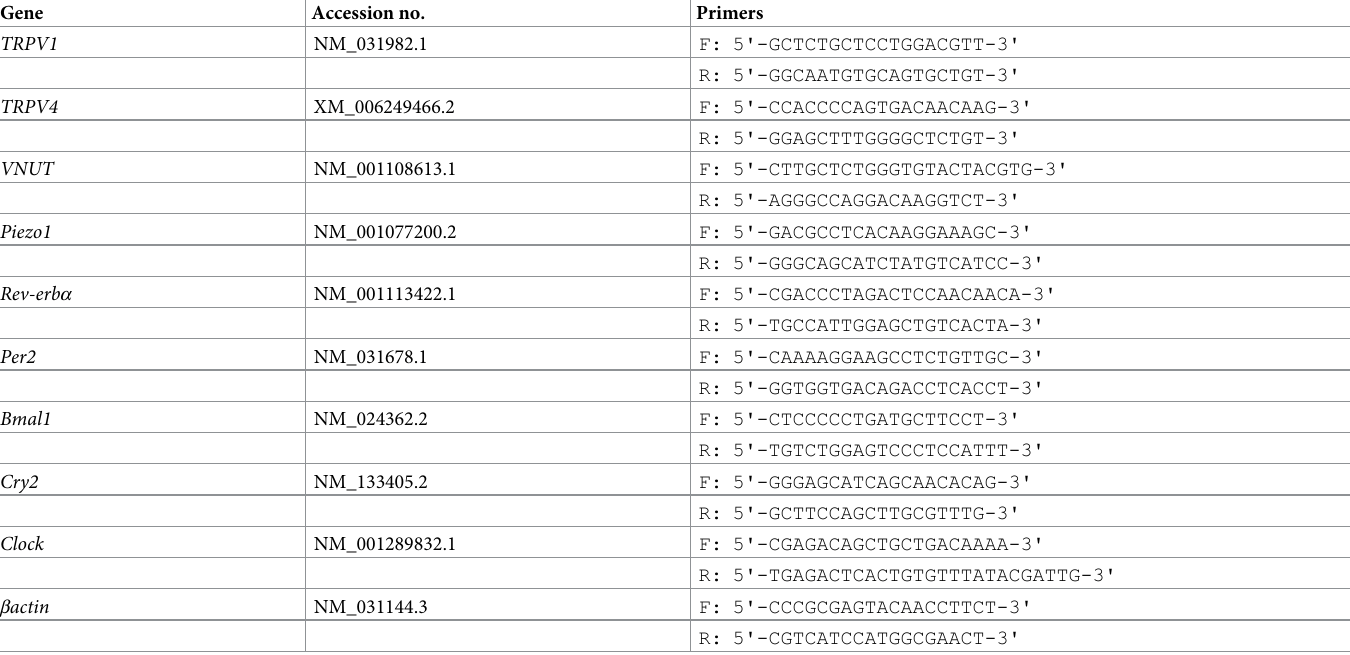
Table 1. Primers used for real-time